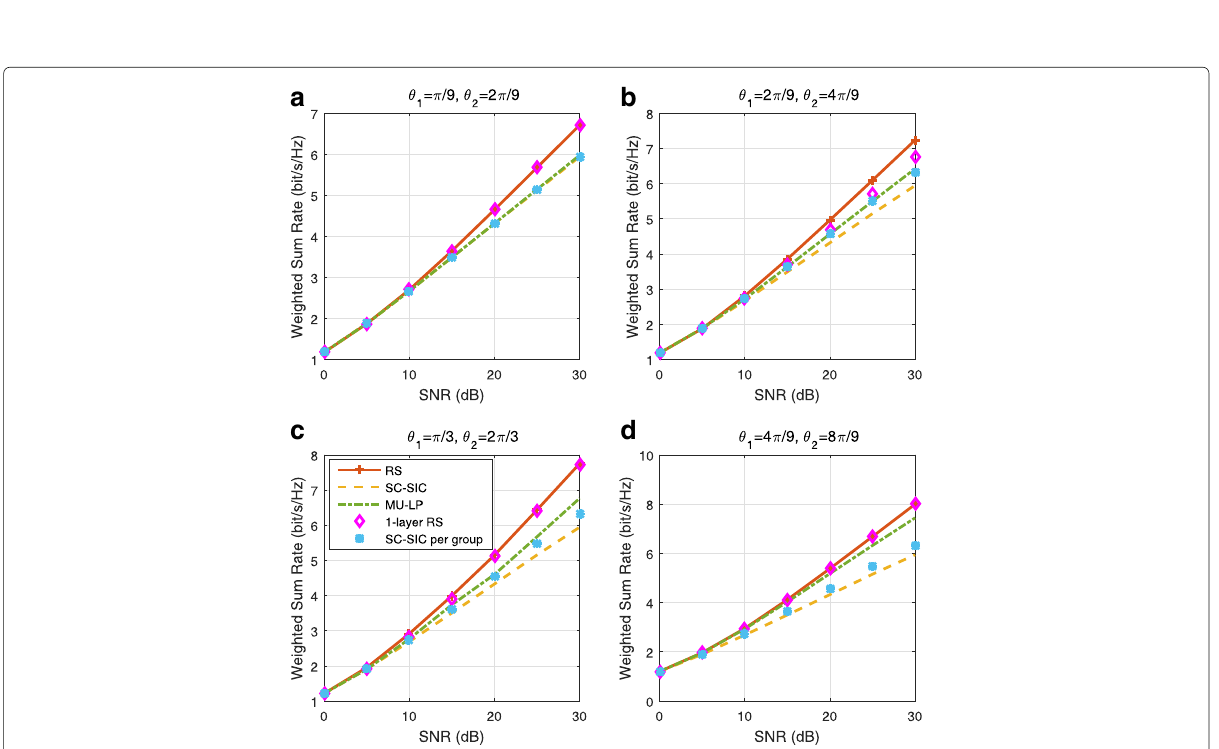
Fig. 47 Weighted sum rate versus SNR comparison of different strategies for underloaded three-user deployment with imperfect CSIT, γ 1 = γ 2 =